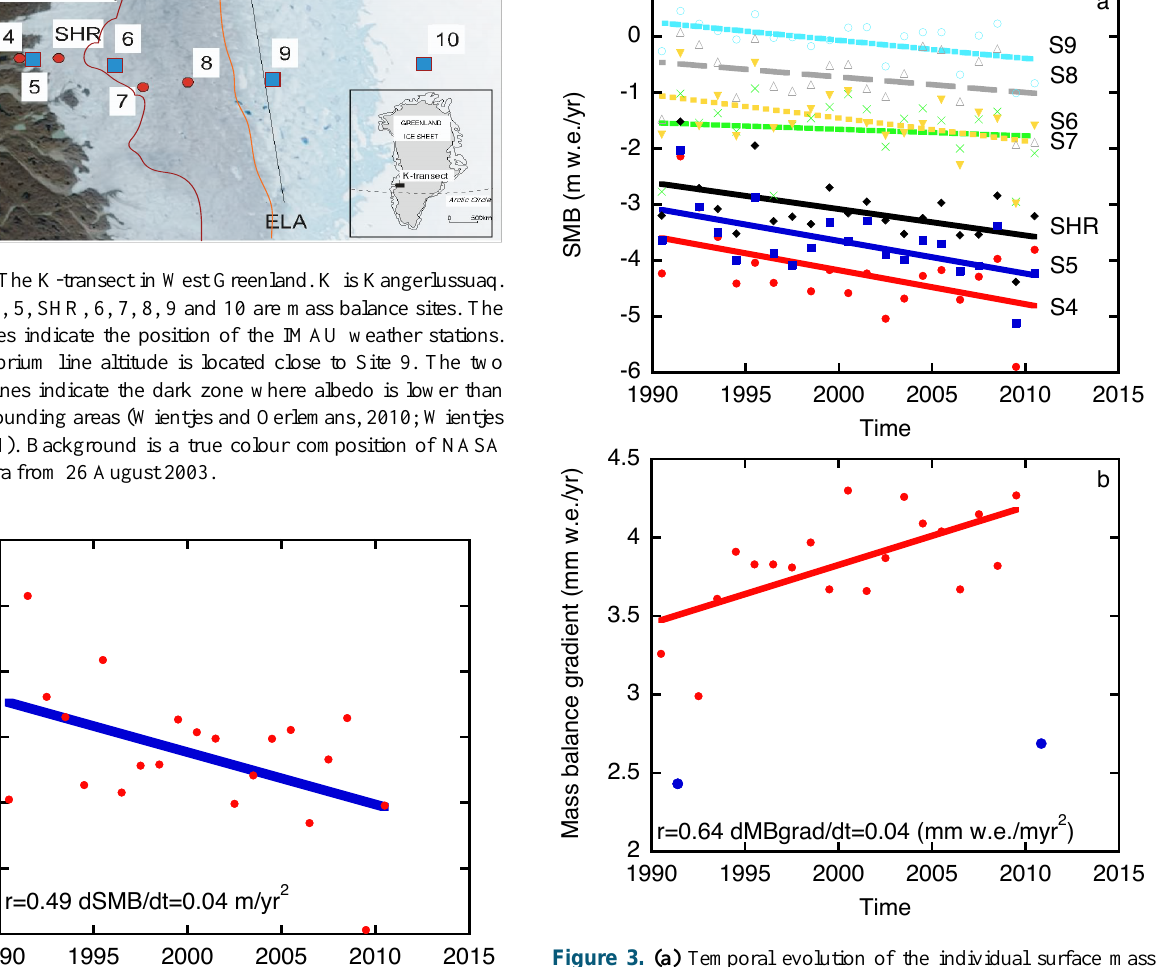
Figure 3. (a) Temporal evolution of the individual surface mass balance sites. Ablation increases over time only near the margin Figure 3: (a) Temporal evolution of the individual surface mass balance sites. Ablation of the ice sheet. Dotted lines are sites higher on the transect with Figure 2. The surface mass balance averaged (S4–S9) over the tran- no significant trend over time. (b) The mass balance gradient as a Figure 2: The surface mass balance averaged (S4-S9) over the transect as a function Figure 3: (a) Temporal evolution of the individual surface mass balance sites. Ablation increases over time only near the margin of the ice sheet. Dotted lines are sites higher sect as a function of time. dSMB / dt is the gradient in the surface function of time. Blue dots are years excluded from the regression of time. dSMB/dt is the gradient in the surface mass balance, blue line derived from mass balance, blue line derived from linear regression. analysis as explained in the increases over time only near the margin of the ice sheet. Dotted lines are sites higher on the transect with no significant trend over time. (b) The mass balance gradient as a linear regression. on the transect with no significant trend over time. (b) The mass balance gradient as a function of time. Blue dots are years excluded from the regression analysis as function of time. Blue dots are years excluded from the regression analysis as explained in the text. explained in the text.